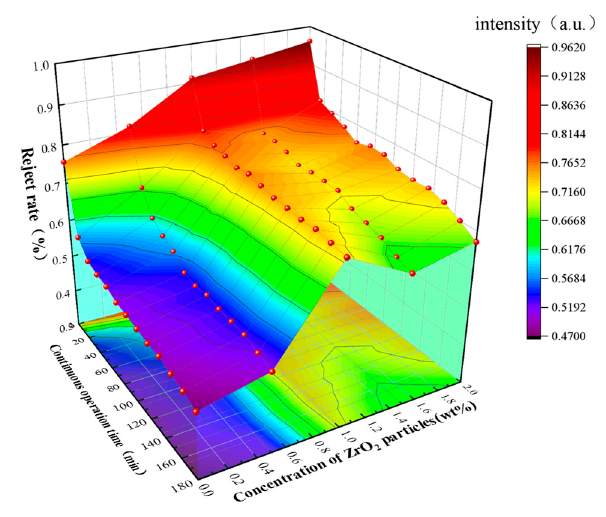
Figure 4. Schematic diagram of ZrO 2 /BCM resistance to contaminant.